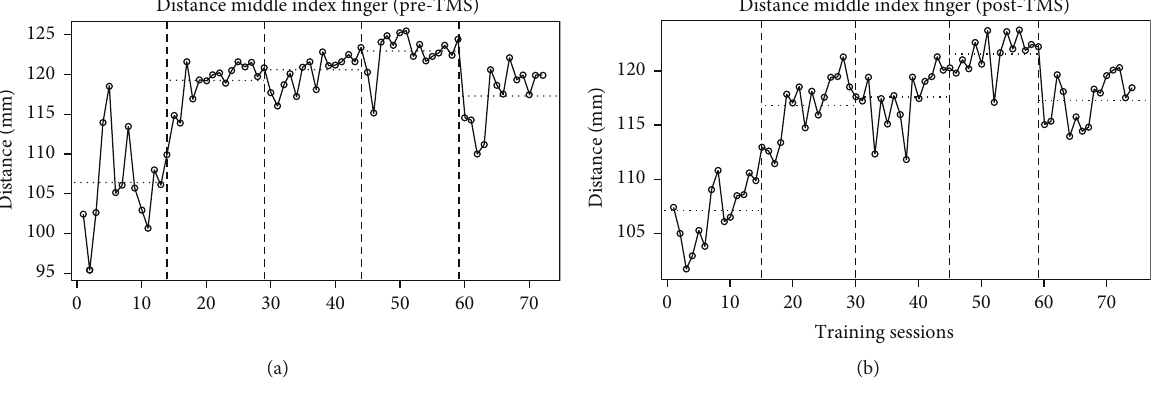
Figure 4: Graphical representation of the trend observed at the pre-rTMS (a) and post-rTMS (b) phases for the distance between the middle and index fi ngers when the former was fl